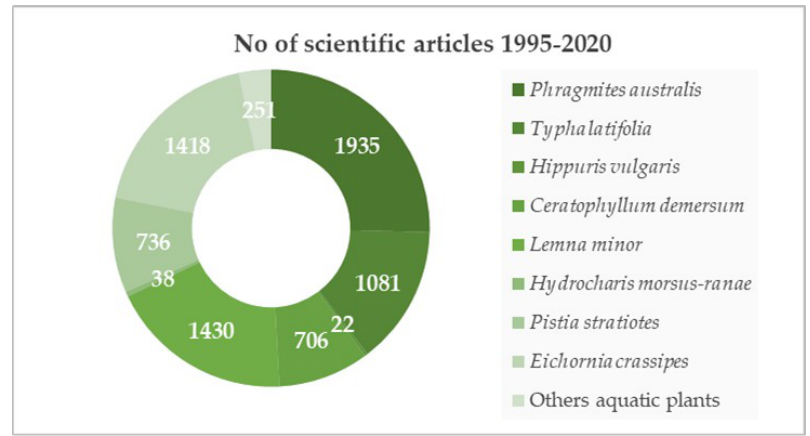
Figure 4. Number of scientific articles from 1995 to 2020 on aquatic plants used in phytoremediation with respect to heavy metals. Table 3. Comparison of removal of metals by some water